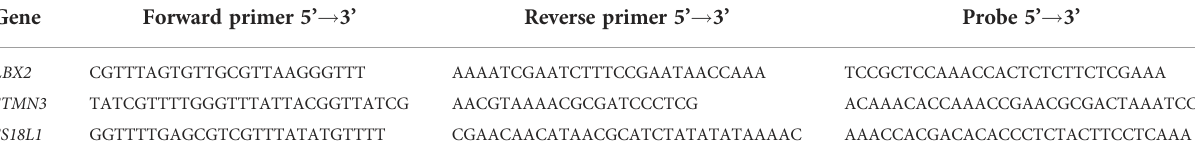
TABLE 2 Designed primer and probe sequences of target genes.